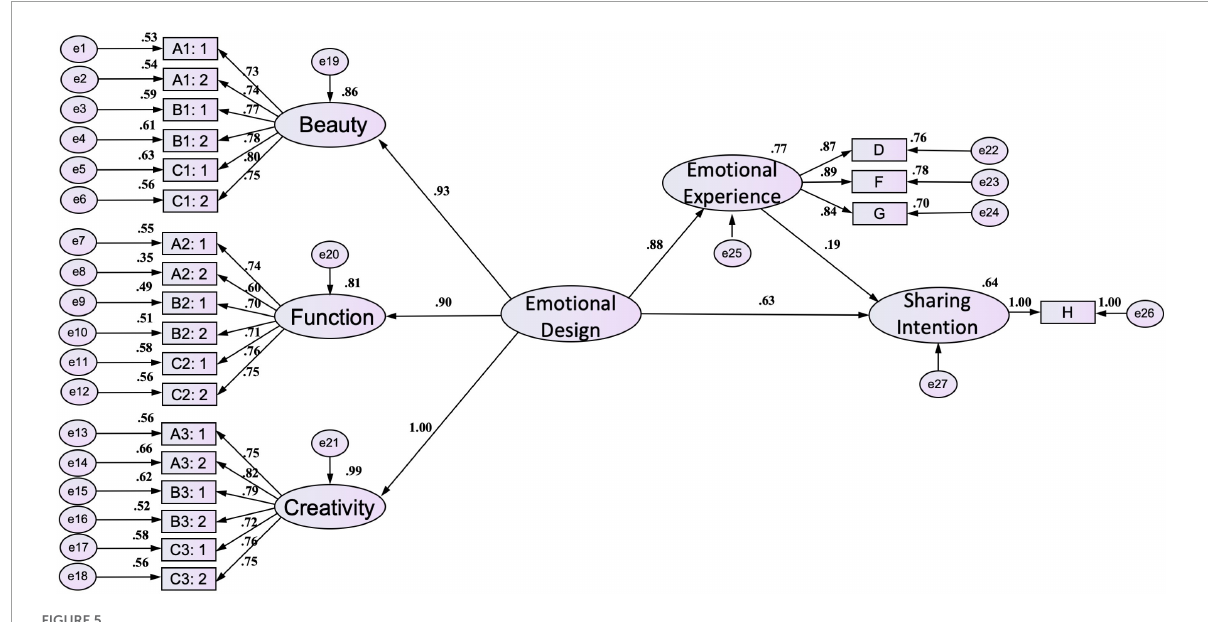
FIGURE5 Path diagram of film & television works structure model in the